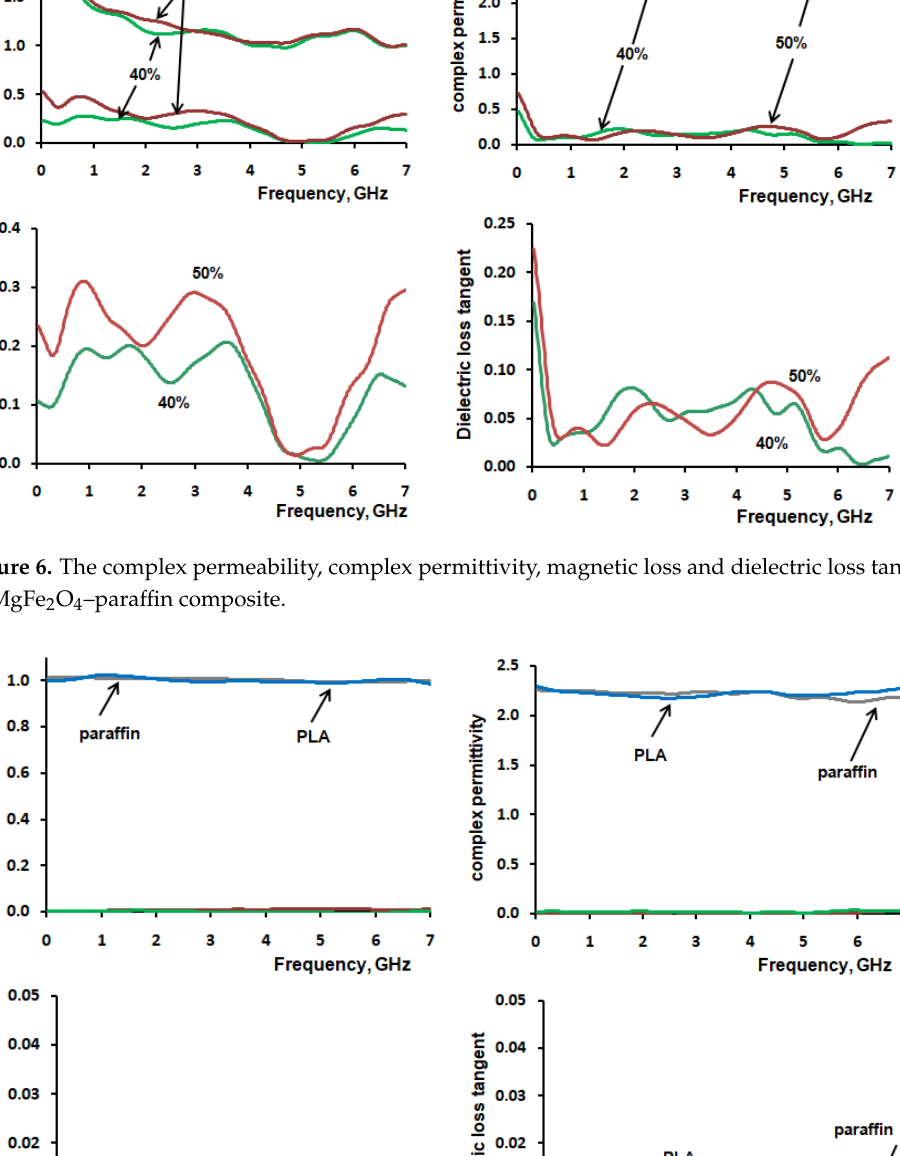
Figure 8. DSC thermograms of MgFe 2 O 4 –PLA composites.